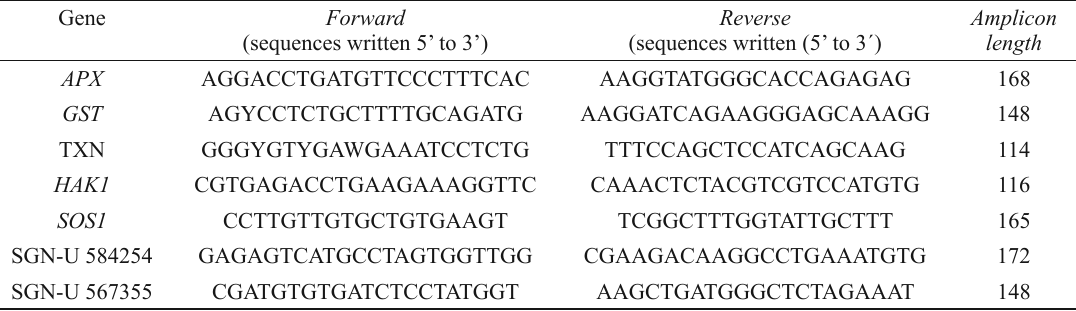
Speci fi c primers used in the real-time RT-qPCR